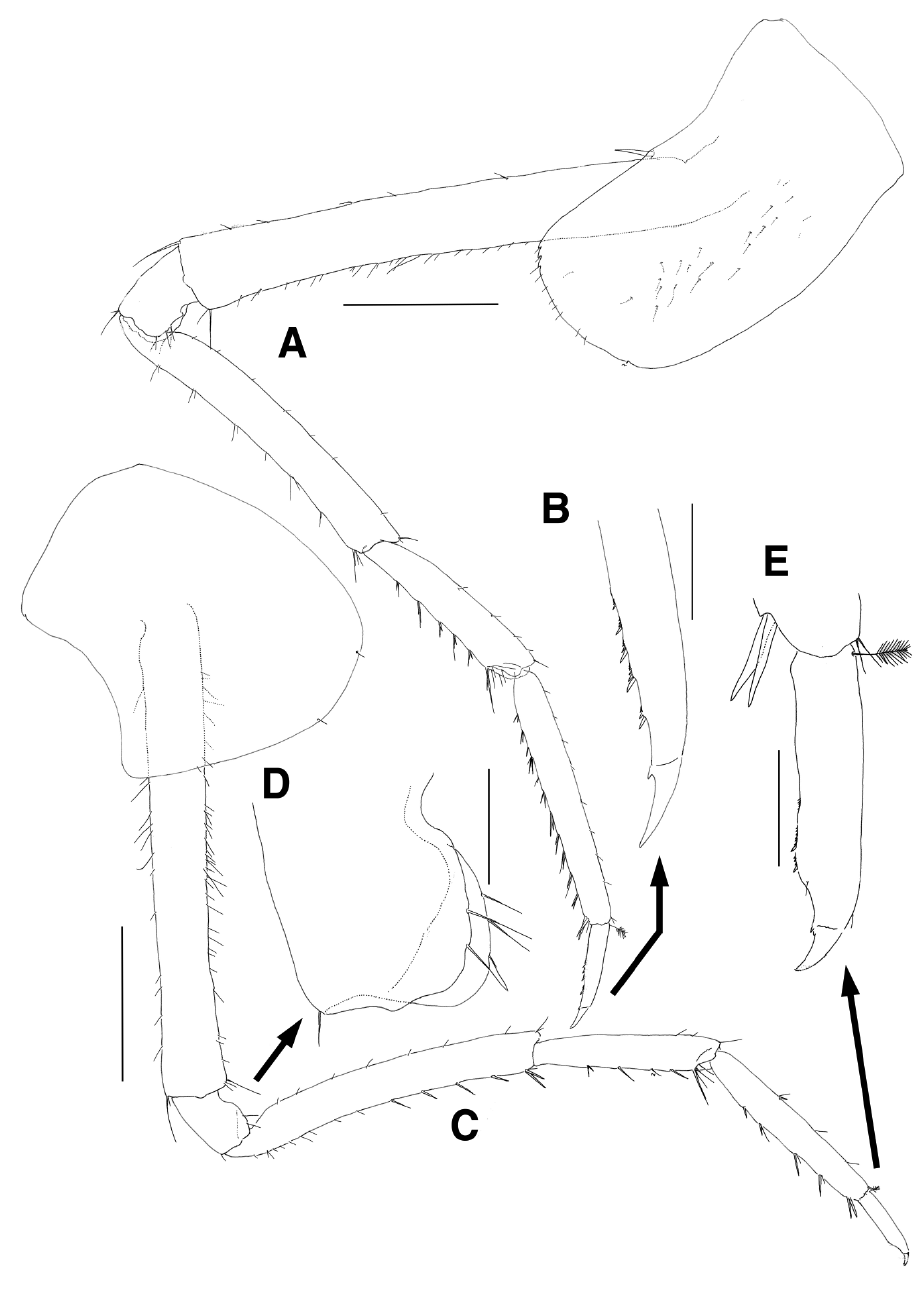
Figure 4. Eusirus bulbodigitus sp. n., holotype, male, NIBRIV0000332003, 11.3 mm. Jeju Island, South Korea. A Pereopod 3 B Dactylus of pereopod 3 C Pereopod 4 D Ischium of pereopod 4 E Dactylus of pereopod 4. Scale bars=0.1 mm ( B, D, E ), 0.5 mm ( A, C